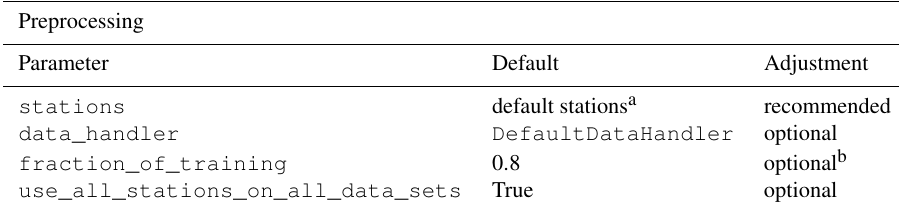
Figure 13. Skill score of bootstrapped model input predictions separated for each input variable ( x axis) and forecast steps (dark to light blue) with the original (non-bootstrapped) predictions as reference. PlotBootstrapSkillScore is only executed if bootstrap analysis is enabled. Table 2. Summary of all parameters related to the preprocessing that are required, recommended, or optional to adjust for a custom experiment